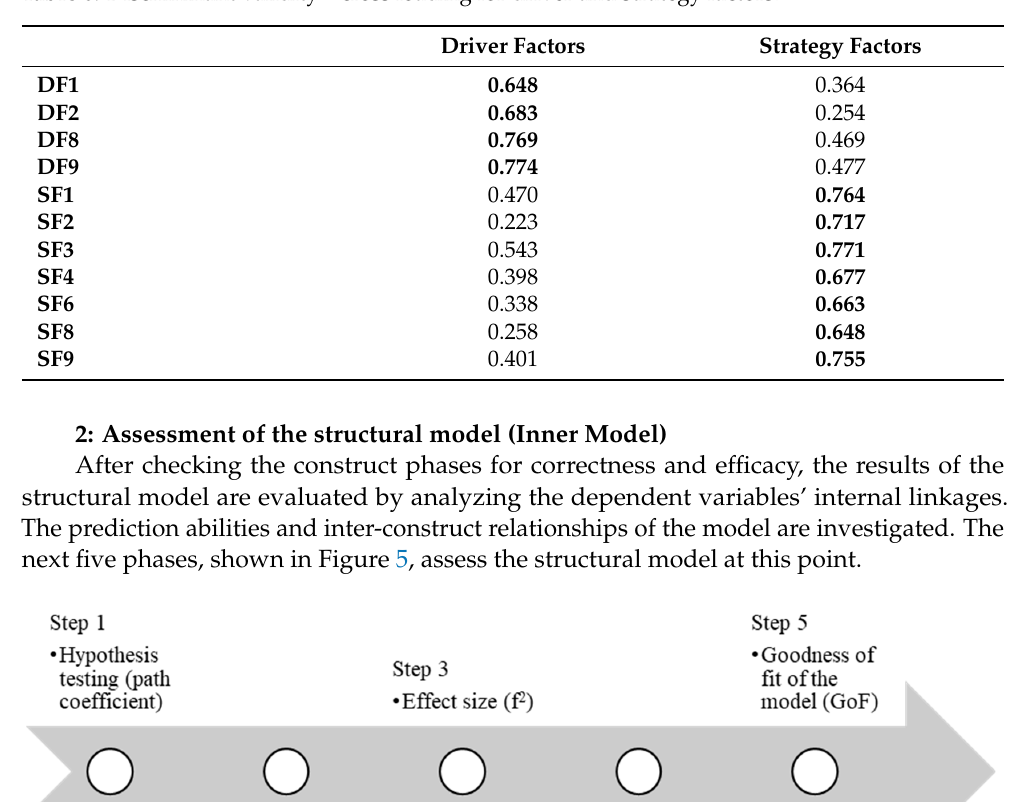
Table 6. Discriminant validity—cross loading for driver and strategy factors.